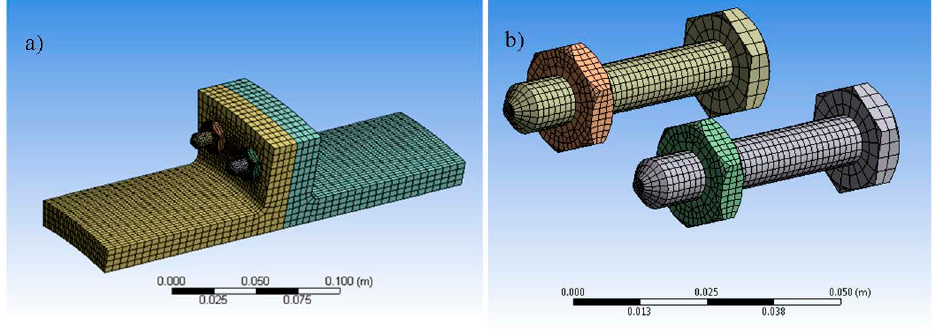
Figure 3. Hexahedron connection was used to map and mesh the ( a ) the flange ( b ) the bolts and nuts.